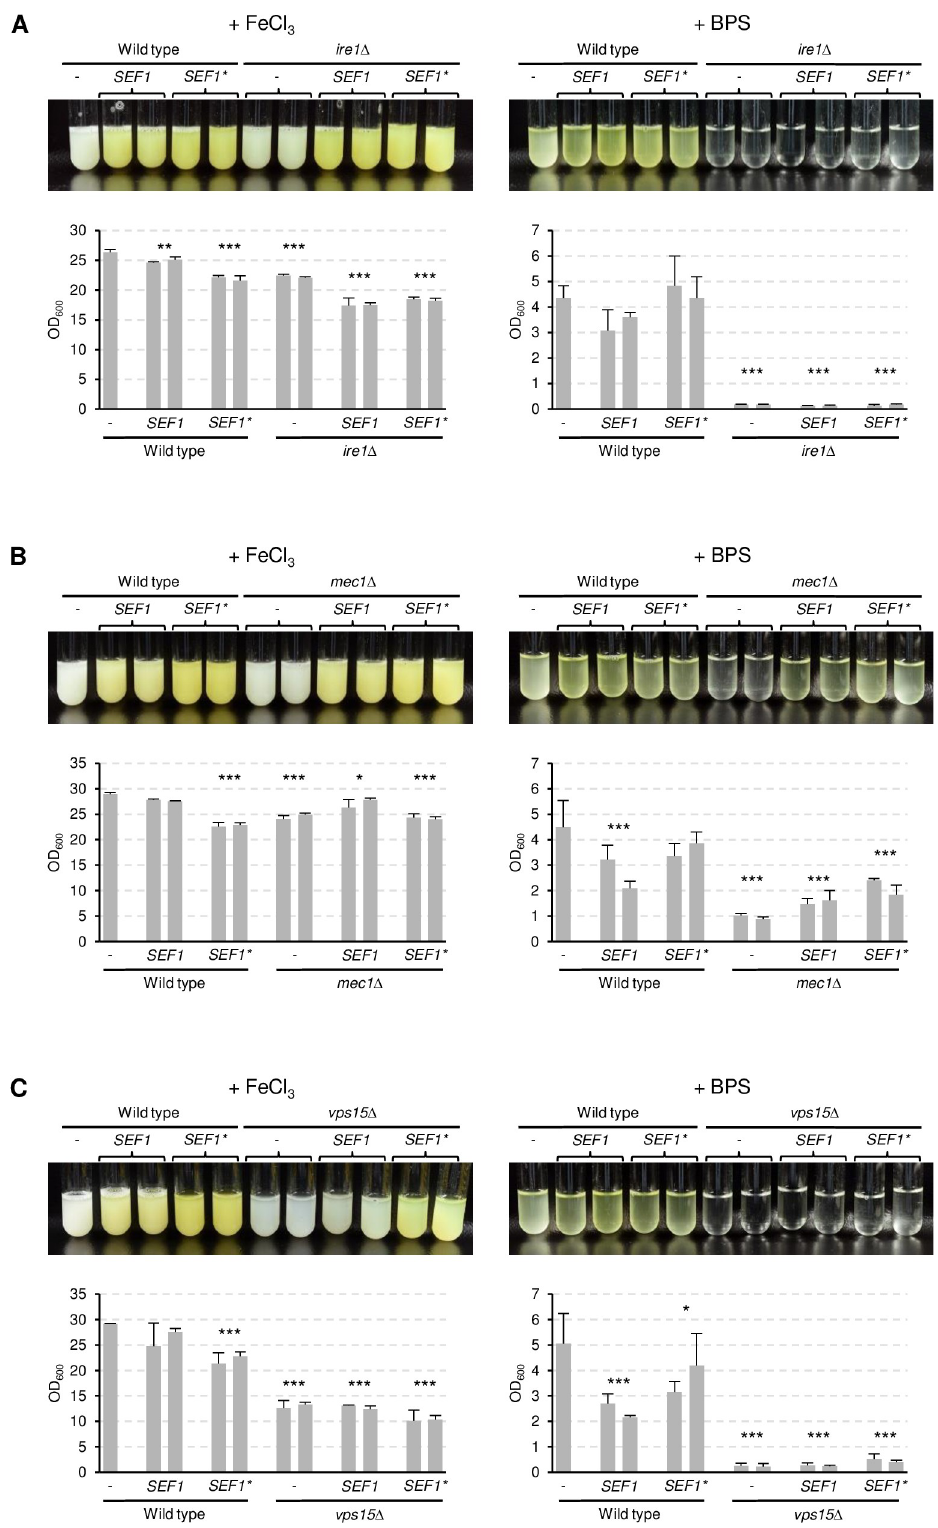
Fig 4. Sefl is functional in the absence of Ire1, Mec1, and Vps15. Strains overexpressing wild-type SEF1 or the hyperactive SEF1 � in ire1 Δ (A), mec1 Δ (B), and vps15 Δ (C) backgrounds were grown in minimal medium